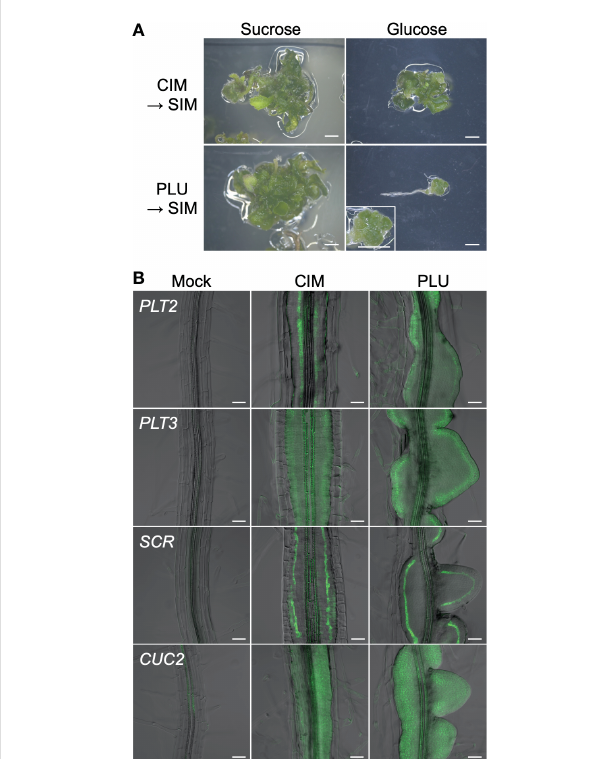
FIGURE 2 PLU-induced callus retains shoot regeneration potency. (A) Root explants from wild-type seedlings at 5 dpi were cultured on CIM or 40 µM PLU-containing medium with sucrose or glucose for 6 days, transferred to SIM, and further cultured for 19 days. The enlarged image in the lower-right panel shows a mass of green cells that did not develop further. Scale bars: 2 mm. (B) Roots explants from seedlings of reporter lines at 5 dpi were cultured on PLU- supplemented medium or CIM for 6 days. Fluorescent signals of PLT2pro:Eluc-3xVenus , PLT3pro:Eluc-3xVenus SCRpro:4xYFP ,